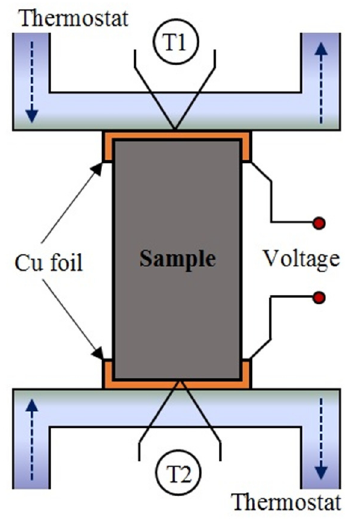
Figure 2. Experimental setup for the determination of thermoelectric properties.